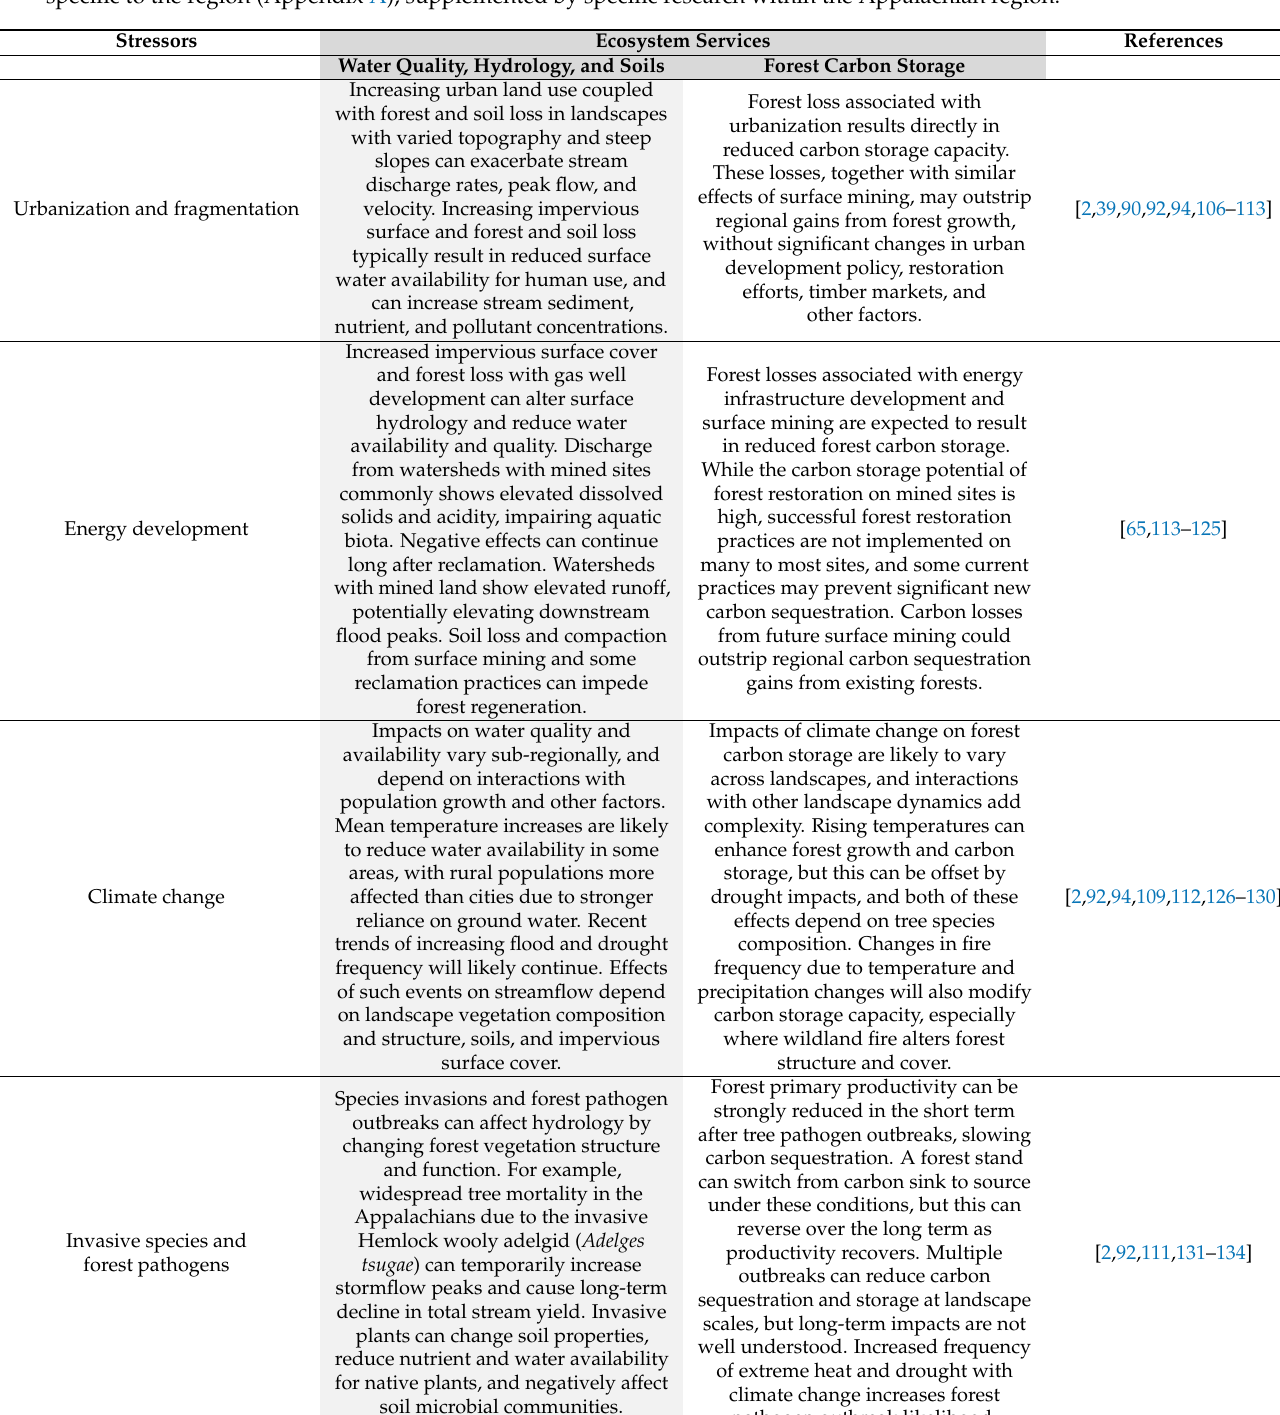
Table A2. The broad ES and stressor categories included here are not exhaustive but were represented in multiple regional assessments (Figure 2). The top half of the table intersects ES (columns) with stressors (rows); the bottom half of the table intersects additional ES with the same stressors. References include regional or national ecological assessments with findings specific to the region (Appendix A), supplemented by specific research within the Appalachian